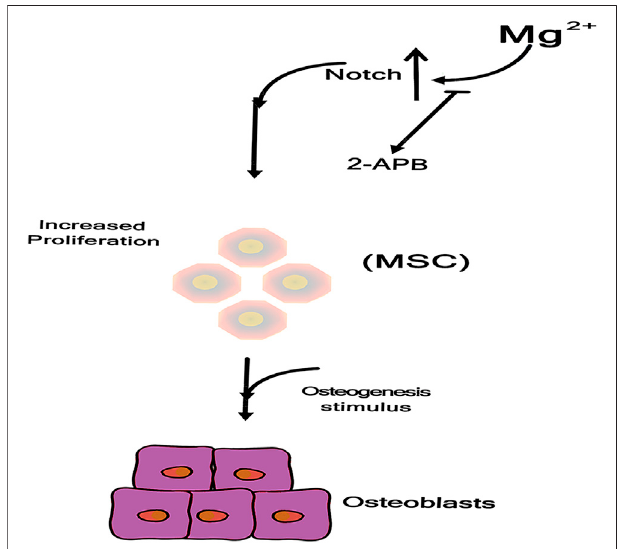
FIGURE5| MgionsenterintoMSCthroughTRPM7channel,increasing Notch Intracellular Domain (NICD) nuclear translocation (Díaz-Tocados. et al.,